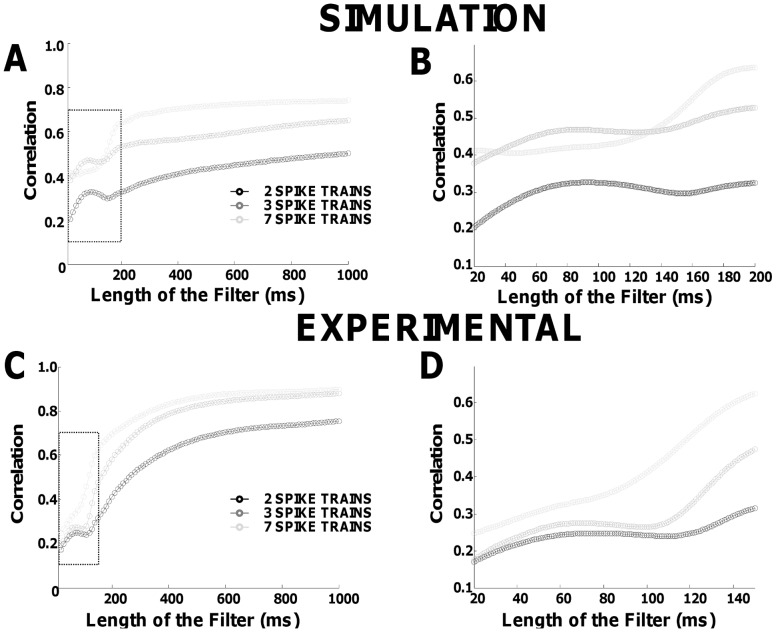
Peak of correlation magnitude between spike trains filtered with Hann windows of different lengths.A, simulations results using combinations of 2, 3 and 7 pooled spike trains. B, inset for the filter lengths in the range 20–200 ms. C, experimental results for subject n. 3. D, inset for the filter length in the range 20–140 ms. Values are reported as the mean across all combinations of the specified number of spike trains. Notice the non-monotonic behavior when the filter length is approximately equal to the mean inter-spike intervals (97±17 ms for simulations and 72±19 ms for experimental).